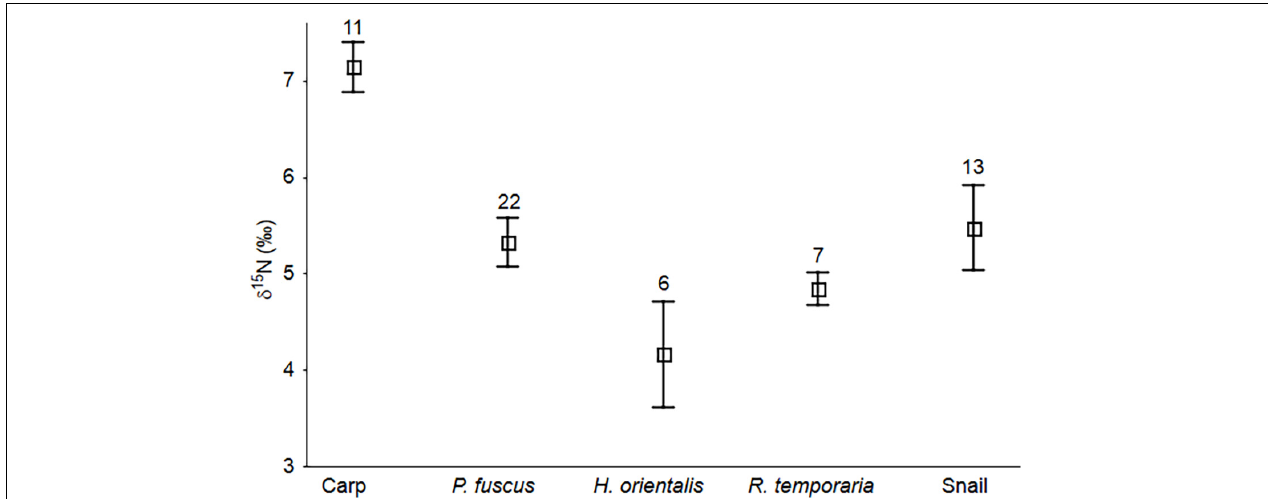
FIGURE 4 | Mean ( ± SE) stable nitrogen isotope values of fish (common carp Cyprinus carpio ), anuran tadpoles ( Pelobates fuscus , Hyla orientalis , and Rana temporaria ) and snails Lymnaea stagnalis. Sample sizes are shown above the whiskers. Common carp was the only species differing (significantly more enriched in 15 N) from the other consumers collected from the study